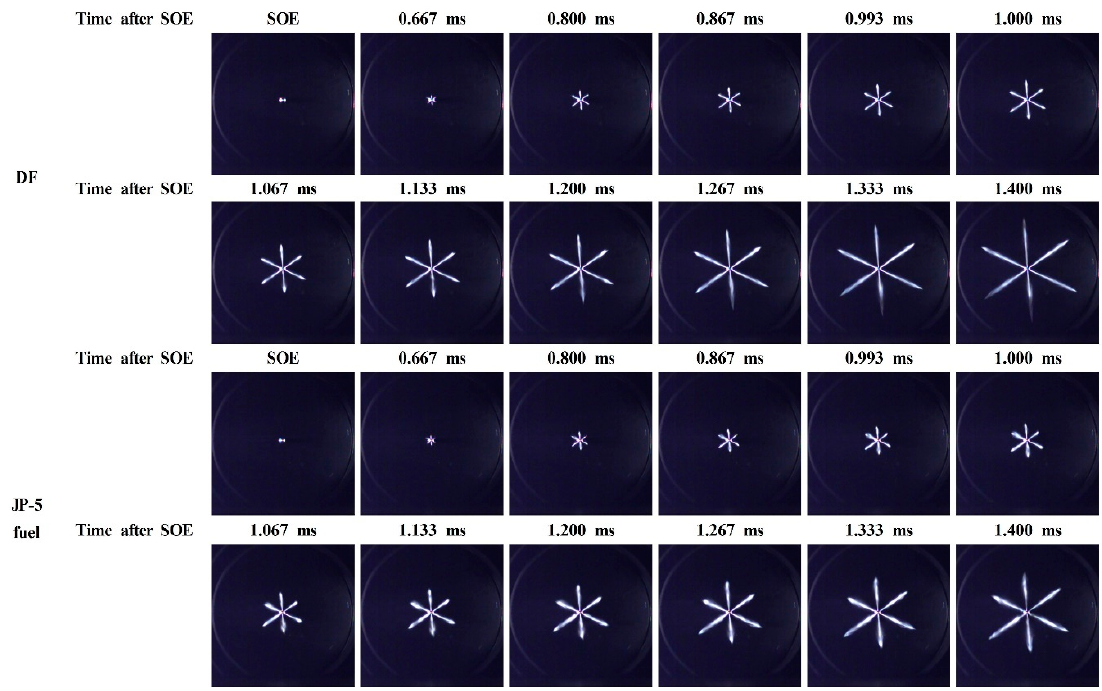
Figure 2. Spray formation process of the DF and JP-5 fuel.